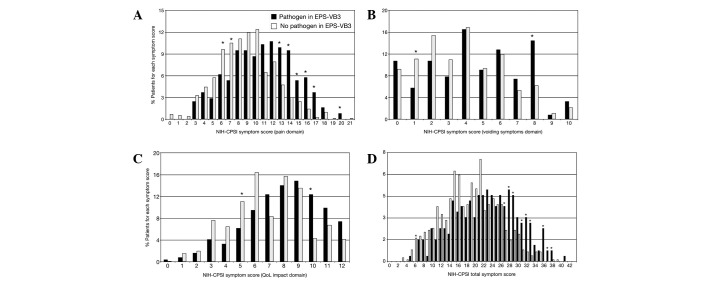
Distribution patterns of National Institutes of Health-Chronic Prostatitis Symptom Index (NIH-CPSI) scores in patients with a positive (black bars) or negative (empty bars) infection domain of the UPOINTS system [i.e. patients with positive or negative microbiological cultures of expressed prostatic secretions (EPS) and/or post-massage voided urine (VB3) specimens from a standard ‘4-glass’ test according to Meares and Stamey (8)]. (A) Pain domain; (B) voiding symptom domain; (C) impact on quality of life (QoL) domain; (D) total NIH-CPSI score. The vertical axes show the percentages of patients with a specific symptom score per-group (infection group vs. no infection group). The comparison between proportions of patients showing the same score in the two groups was performed using the χ2 test. *P<0.05.